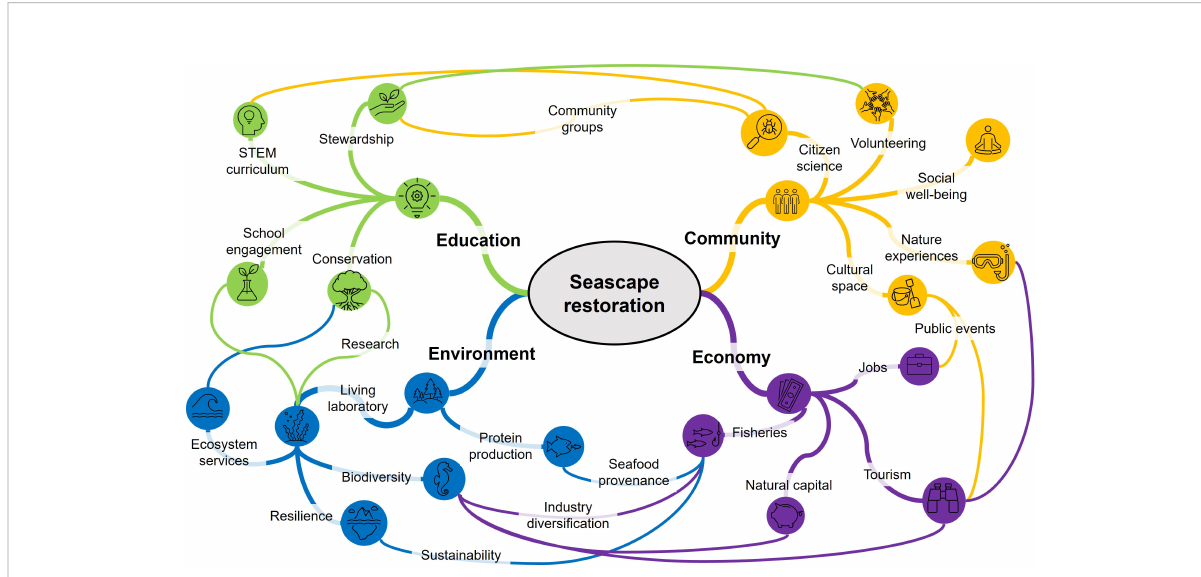
FIGURE 2 A vision of the broad socio-ecological and economic bene fi ts that could emerge where restorations support healthy functional seascapes. Note that all nodes within each of the four sectors are related, and that many more linkages between sector nodes are